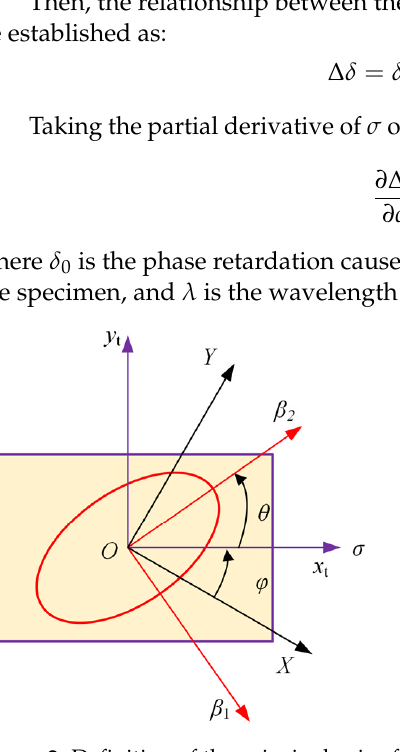
Figure 2. Definition of the principal axis of the permeability tensor and the direction of the uniaxial stress σ in the X - O - Y coordinate system. The directions of β 1 and β 2 coincide with the fast and slow axes, respectively. The direction of the uniaxial stress σ coincides with the x t axis. ϕ and θ are